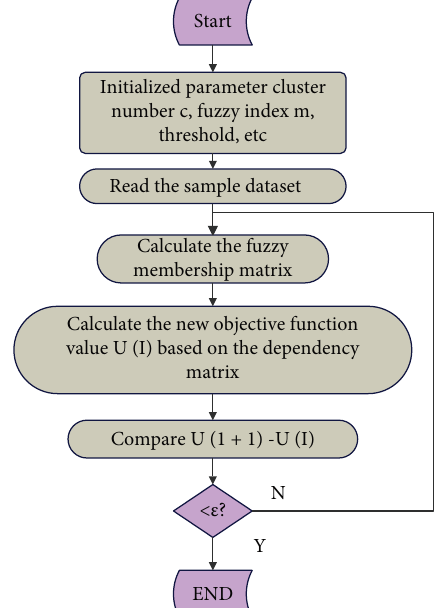
Figure 1: FCM algorithm